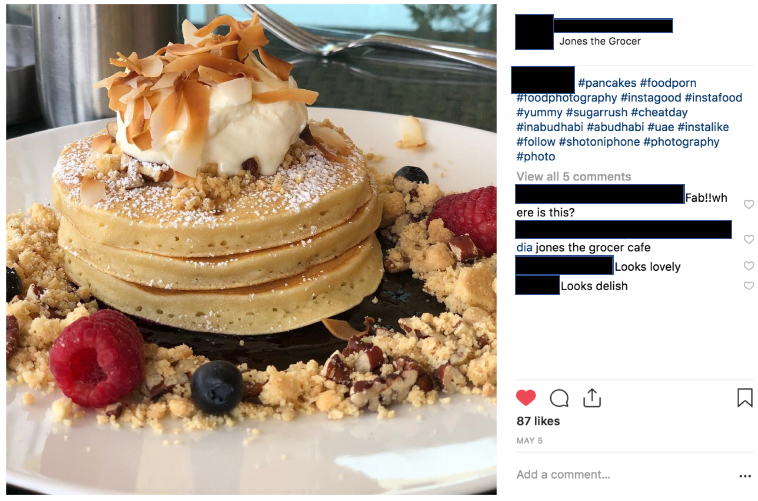
Figure 1. A sample dining-related Instagram post from Abu